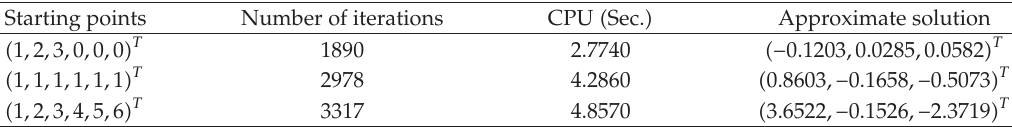
Table 4: Results for Example 6.2 using the HRP method in (cid:5) 2 (cid:6) .